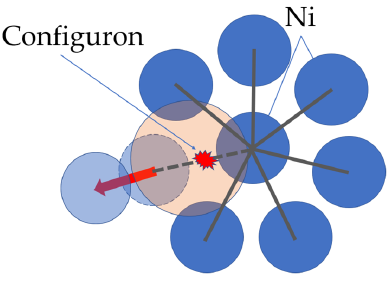
Figure 3. Configuron formation in amorphous nickel due to a change in the local atomic connectivity by losing one nearest neighbor in the first coordination shell. Reprinted with permission from [25].